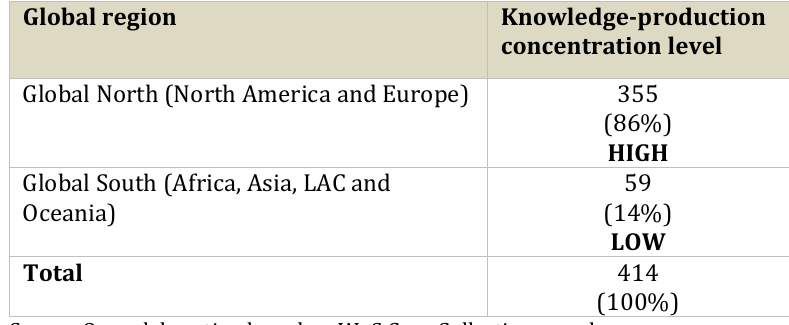
Table 2: Level of knowledge-production concentration in Crimes of the powerful studies globally according to main authors’ affiliations in the Global North/South regions (WoS Core Collection search, n=414 articles)